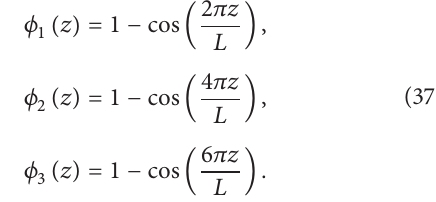
Table 8: Numerical comparison between the results obtained with CDM and [27, 28, 32] of a DWCNT and for different values of parameter 𝜂 0